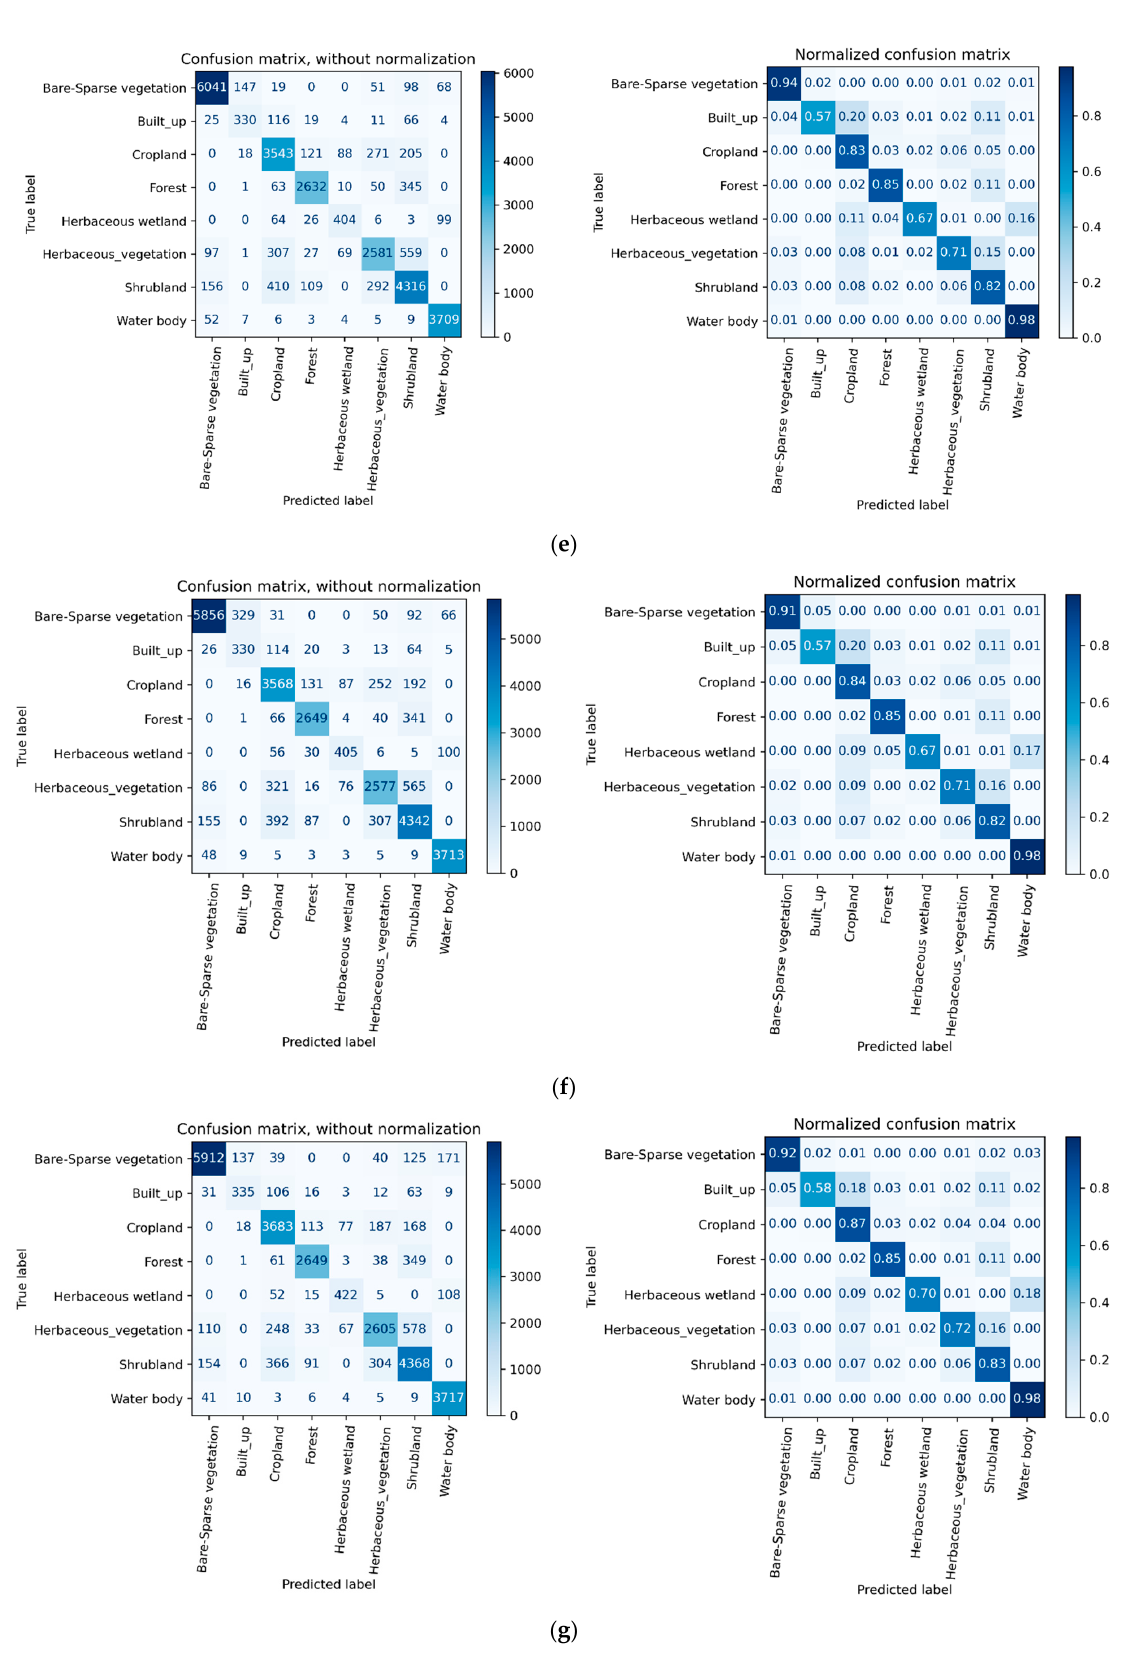
Figure 7. Confusion matrix of the various amount of months. ( a ) Confusion matrix of OMSI; ( b ) Confusion matrix of TMSI; ( c ) Confusion matrix of SMSI; ( d ) Confusion matrix of NMSI; ( e ) Confusion matrix of OYSI; ( f ) Confusion matrix of SDFOYSI; ( g ) Confusion matrix of